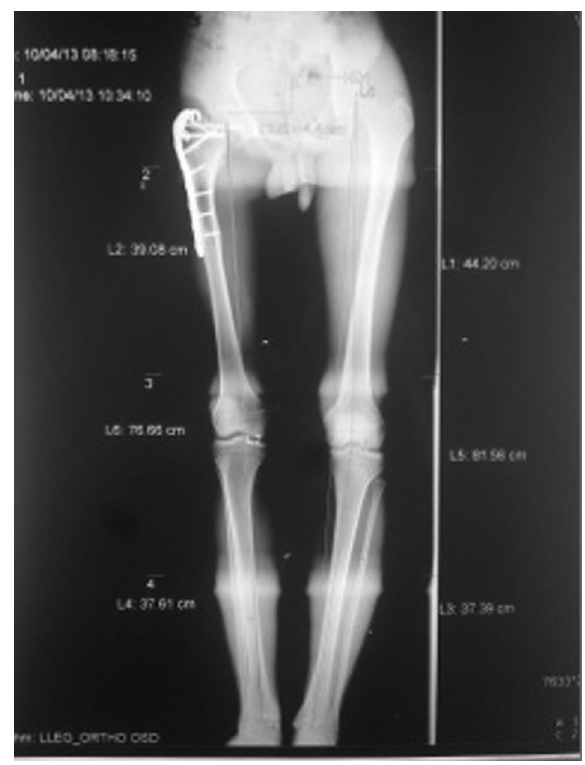
Figure 3. A 17-year-old male with Perthes disease sequelae and preoperative 4-cm shortness of femur (Case No. 5 in Table 1).